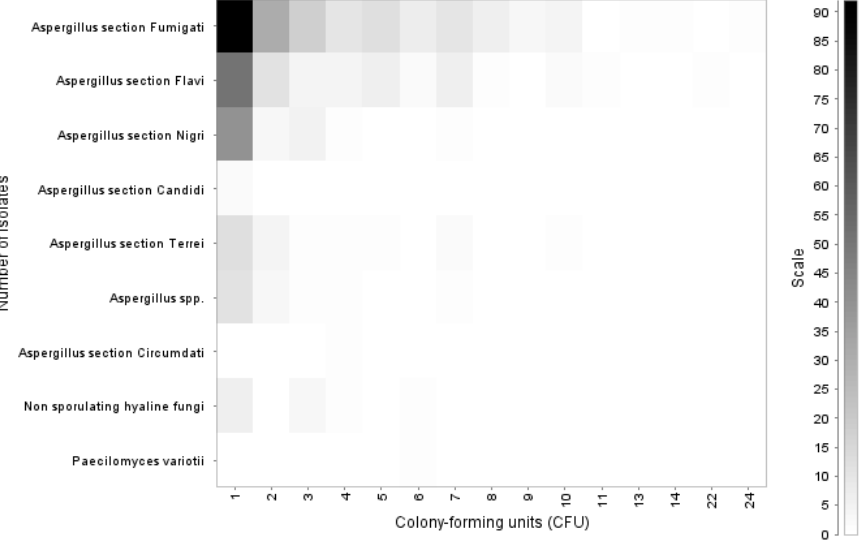
Figure 2. Colony-forming units of fungi isolated in chicken lungs ( Gallus gallus ) during 2008–2021 in the Mycology Laboratory, School of Veterinary Medicine, Universidad Nacional, Heredia, Costa Rica.